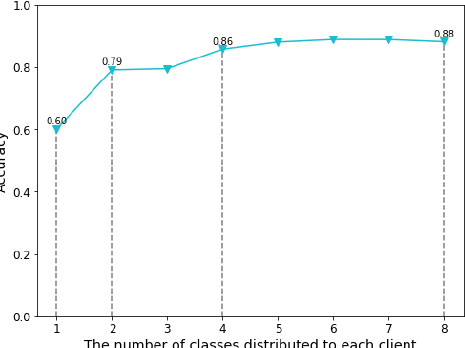
Figure 10. Accuracy of FLIC with the different number of classes distributed to one client (16 clients in